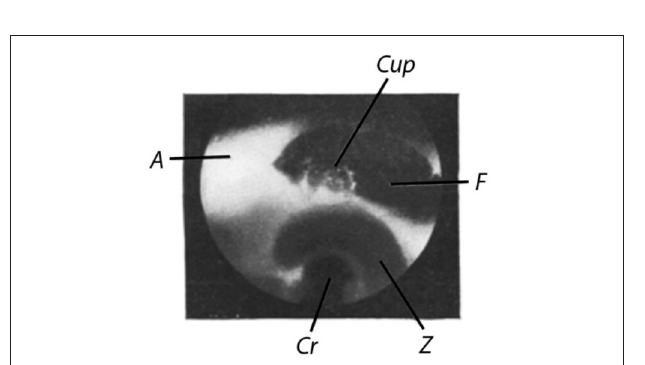
FIGURE 3 | Cupula of a pike. Fixed preparation. Pike with a weight of about 0.5kg. Dissected on May 14, 1927. Image captured on May 18, 1927. Lateral slit lamp illumination. Exposure time: 4min. Cup = cupula; A = ampulla; F = window; Z = zona lunata; Cr = crista (Image number 10).